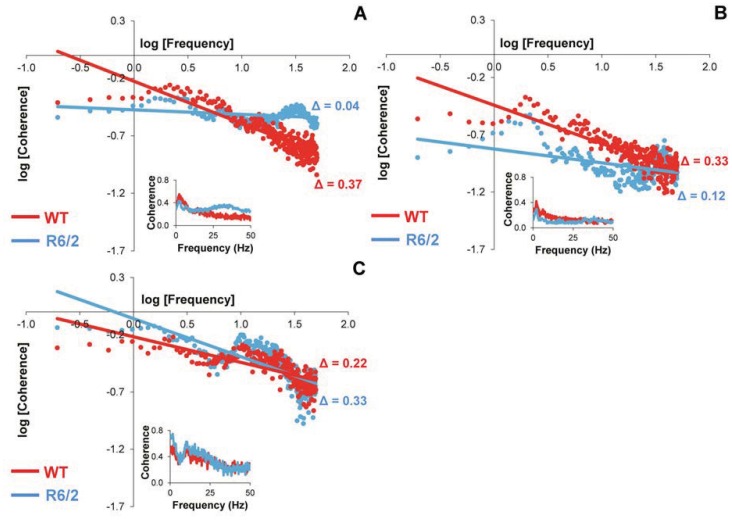
Corticostriatal coherence distributions.Log-log plots show the mean coherence spectrum across the frequency range from WT (red circles) and R6/2 (blue circles) mice during quiet rest (A), grooming (B), and quiet exploration. The correspondingly colored lines denote the least-squares fits to the coherence data. Slope values (Δ) for the fitted functions are provided adjacent to the lines of best fit in similar colored font. Data in their original linear coordinates are presented as insets in each panel.